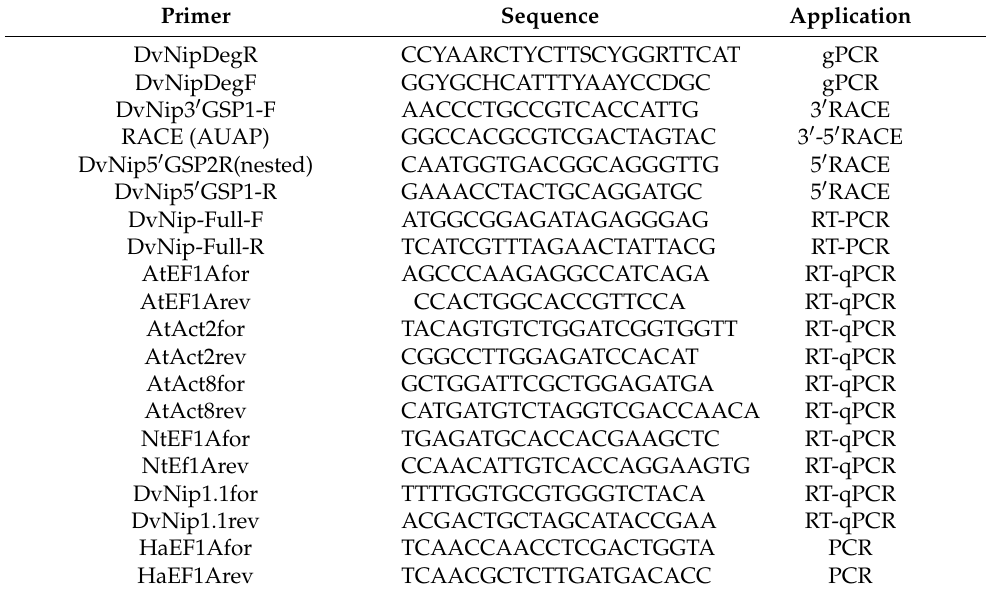
Figure 2. Phylogenetic analysis of plant NIPs1. The sequences were retrieved from NCBI genbank: >inula nip ( Dittrichia viscosa ); >PWA69246.1 NOD26-like intrinsic protein 1,2 ( Artemisia annua ); >XP_023743033.1 aquaporin NIP1-2-like ( Lactuca sativa ); >XP_024983052.1 aquaporin NIP1-1-like